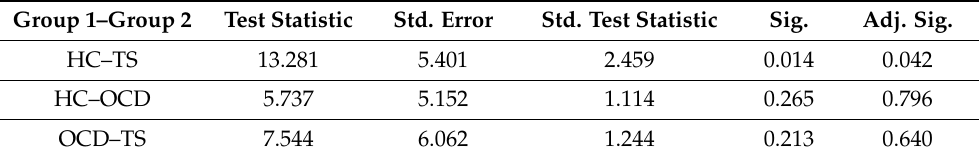
Table A9. Testing for significant group differences using the Bonferroni post-hoc test in the Wender Utah Rating Scale-Kurzform (WURS-K). Abbreviations: Adj. Sig., adjusted significance; HC, healthy control subjects; OCD, obsessive-compulsive disorder; p , asymptotic significance; Sig., significance; Std., standard; TS, Tourette syndrome.